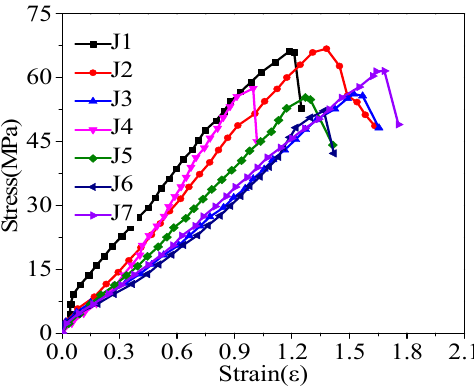
Figure 3. Stress-strain analysis of concrete.